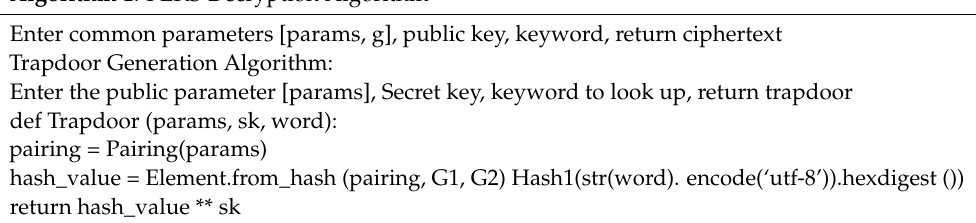
Algorithm 1 : PEKS Decryption Algorithm